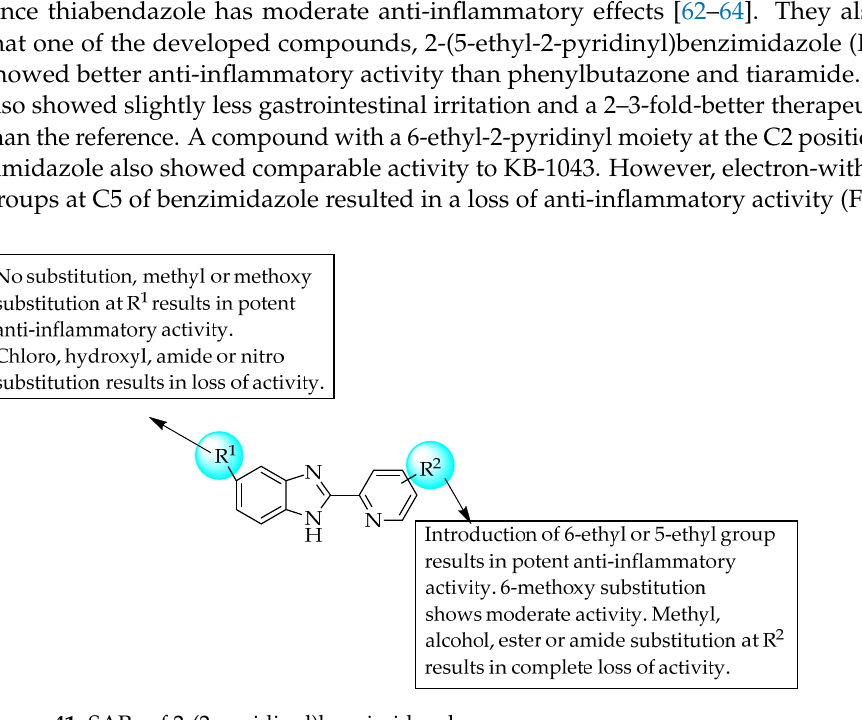
Figure 41. SARs of 2-(2-pyridinyl)benzimidazoles. Ravindernath and Reddy (2017) reported the anti-inflammatory activity of benzo[d]- imidazolyl tetrahydropyridine carboxylates in carrageenan-induced inflammation/oedema in rat hind paws. They found that all the synthesised compounds had moderate anti- inflammatory activity (0.18 to 0.43 at 4 h, volume of oedema (mL)) compared to the standard drug diclofenac sodium (0.60 ± 0.02 at 4 h; control, 3.25 ± 0.03 at 4 h, volume of oedema (mL)). An unsubstituted phenyl or phenyl substituted with 2-position electron-withdrawing groups or 4-position electron-donating groups at R 1 resulted in potent anti-inflammatory activity. Meanwhile, an ortho phenolic substitution at R 2 fa- voured anti-inflammatory activity (Figure 42) [65].